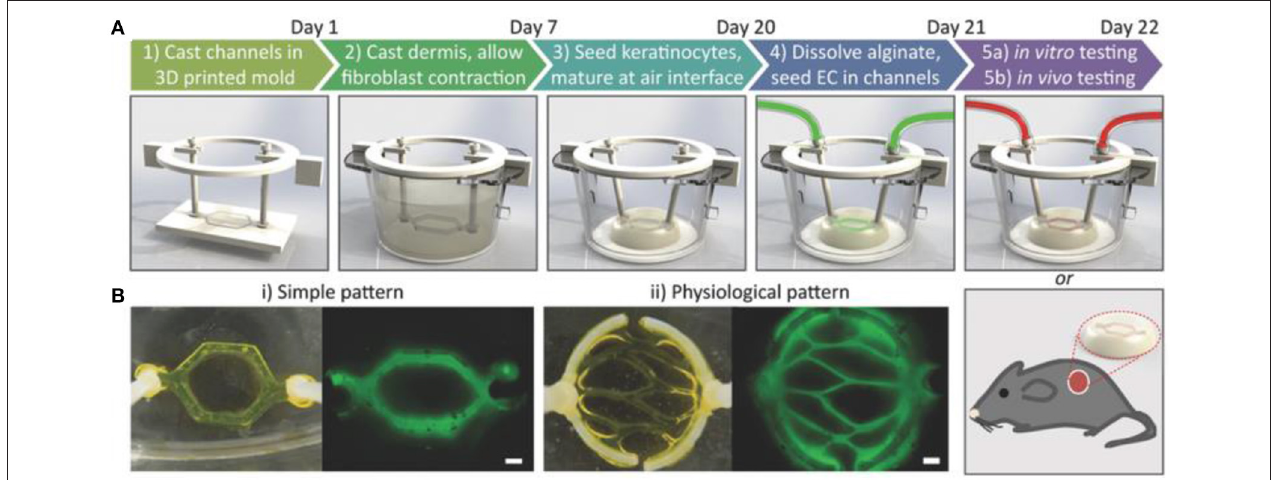
FIGURE 8 | Development of vascularized human skin equivalents. (A) Schematic description of the protocol to develop human skin equivalents. (B) Two different vasculature patterns were generated using fluorescently tagged alginate. Scale bar: 600 µ m. Reprinted with permission from Abaci et al. (2016). Copyright 2016, John Wiley &